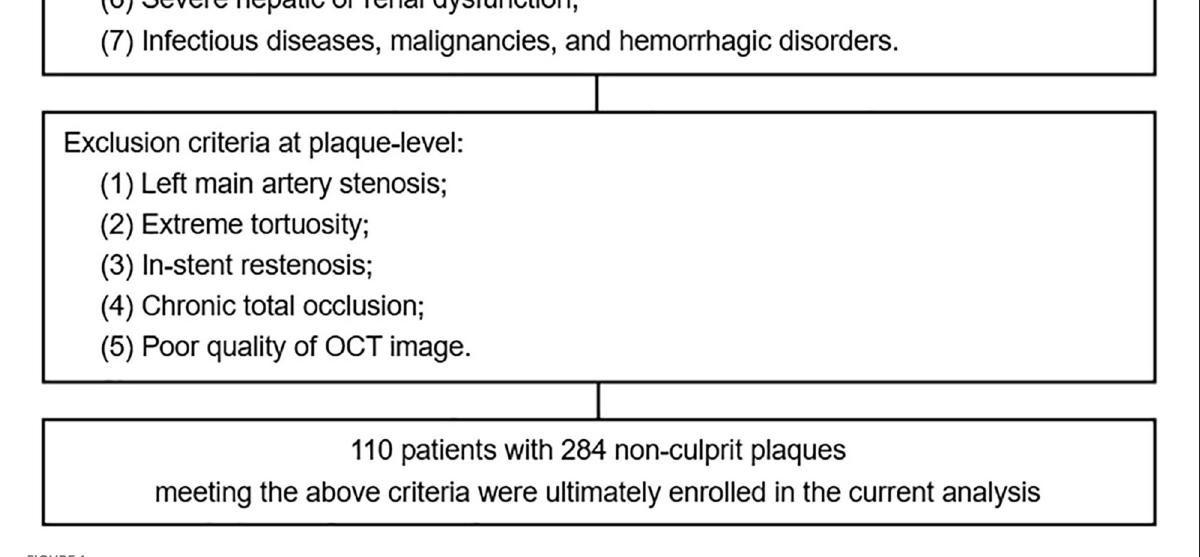
FIGURE1 Flow diagram for the current study. STEMI, ST-segment elevation myocardial infarction; NSTE-ACS, non-ST-segment elevation acute coronary syndrome; OCT, optical coherence tomography; BMI, body mass index; TG, triglyceride.